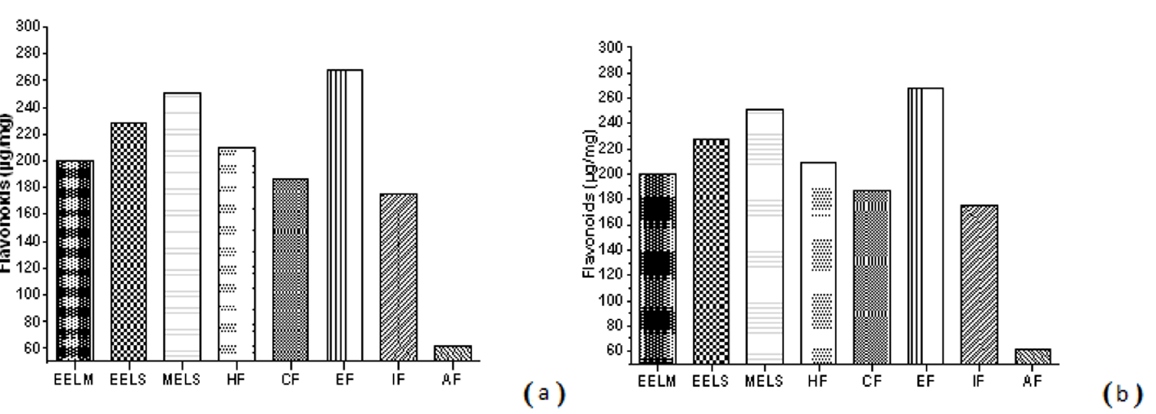
Figure 3 - Total flavonoid extracts from the Stevia leaves UEM-13 expressed as µg of quercetin equivalent per extract/mg ( a ) and µg of rutin equivalents per extract/mg; ( b ) µg of quercetin equivalents per extract/mg. The letters represent the following: EELM: Ethanolic Extract of Leaves (maceration); EELS: Ethanolic Extract of Leaves (Soxhlet); MELS: Methanolic Extract of Leaves (Soxhlet); HF: Hexane Fraction; CF: Chloroform Fraction; EF: Ethyl acetate Fraction; IF: Isobutanol Fraction, AF = Aqueous Fraction.